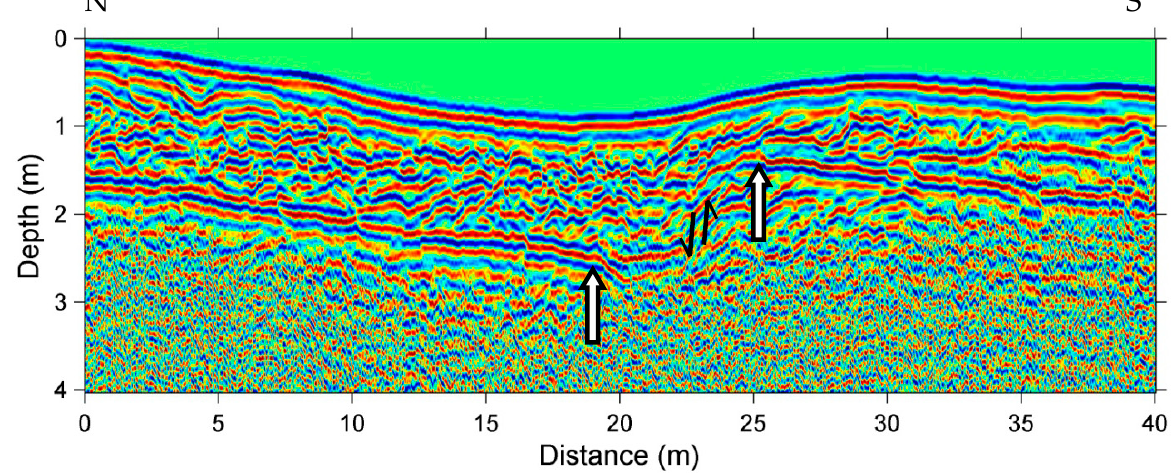
Figure 4. GPR image of the profile at the southeastern part of the Songino fault (transtensional fault zone, see red arrow of Figure 2) obtained with a 250 MHz antenna. The topographic correction is performed using a velocity of 0.1 m/ns. The GPR image shows a strong reflection (white arrows) that is affected and shifted by recent deformation. The black arrows indicate the apparent vertical movement along the fault zone.